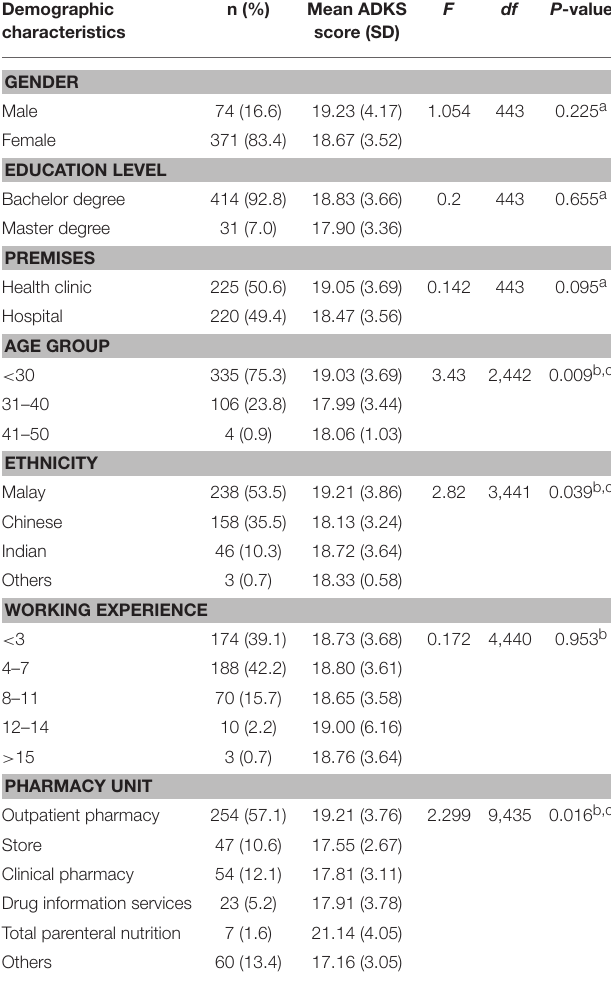
TABLE 1 | Demographic characteristics and their relationship to AD knowledge ( n = 445). Demographic